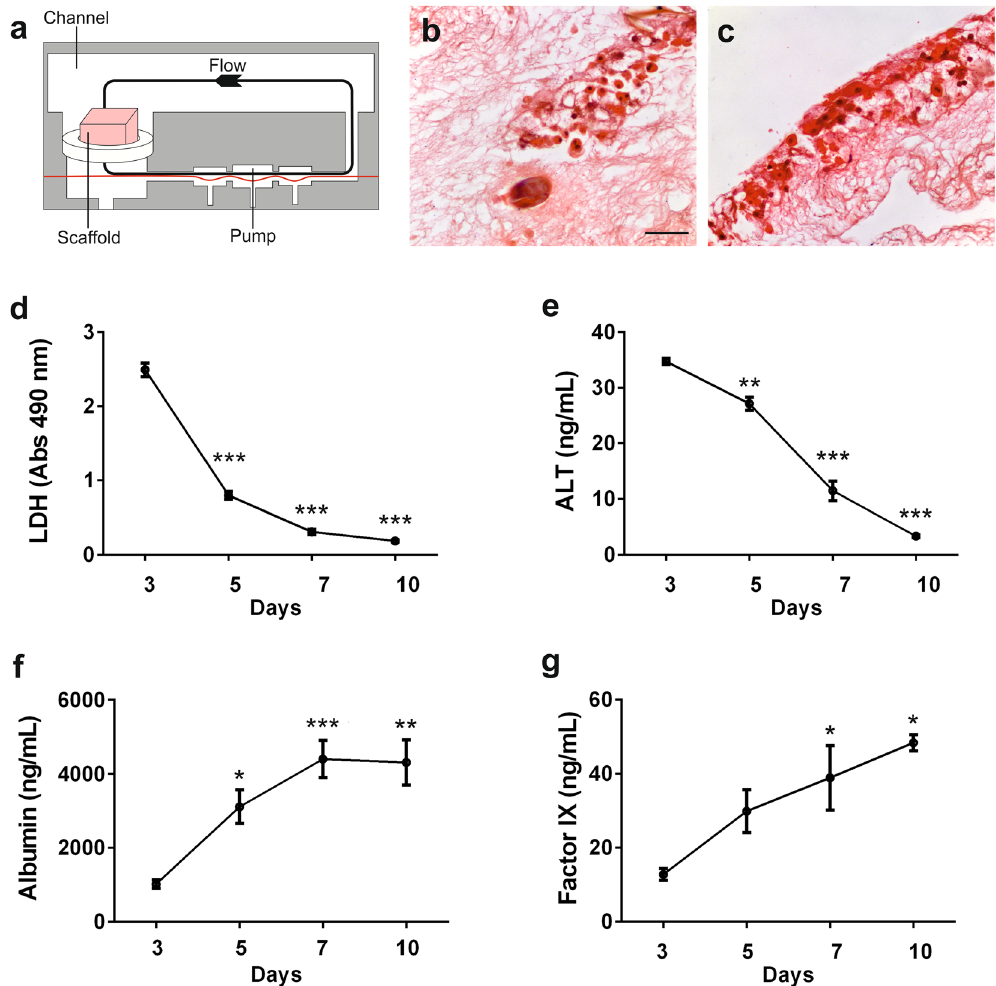
Figure 5. Biocompatibility of ALTCs with primary hepatocytes in a dynamic perfusion culture system.: Human primary hepatocytes cultures were established in ATLC using the LiverChip dynamic system for up to 10 days. ( a) Schematic representation of ALTCs with cells in the perfusion system. H&E staining showing the attachment of primary hepatocytes in the, ( b) , core and, ( c) , outer surface of the ALTC after 10 days in culture. Hepatocytes supernatants were collected every 48 hours for measurement of lactate dehydrogenase (LDH), alanine aminotransferase (ALT), Albumin, and factor IX. Data are expressed as mean ± s.e.m. and analysed via one-way ANOVA with Dunnet’s multiple comparisons test, * p < 0.05, ** p < 0.005, *** p < 0.0001. Scale bars, 50 μ m. Biological replicates (n = 6) are performed for all